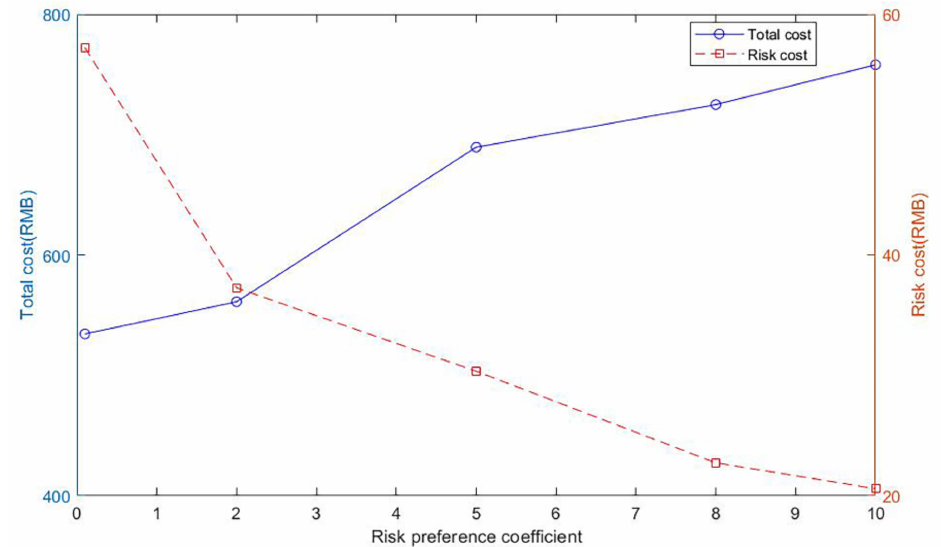
Figure 8. The relationship between running cost and risk preference coefficient.